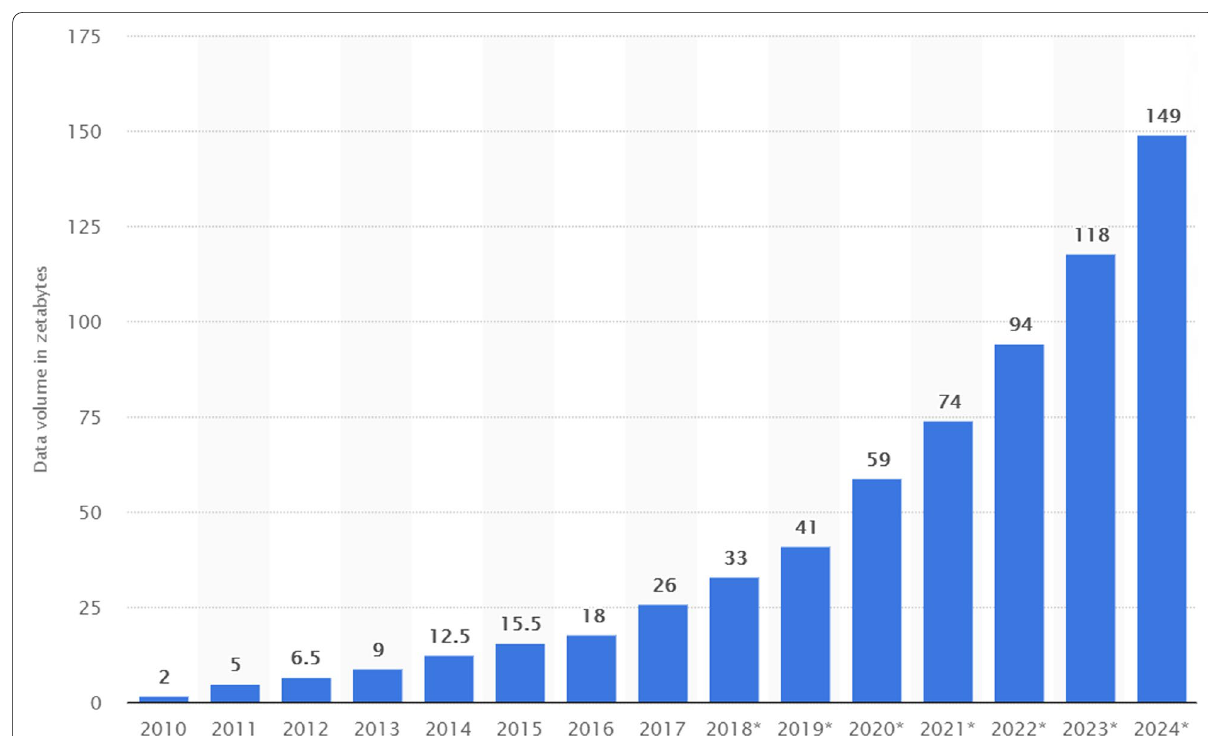
Fig. 1 Volume of data/information created, captured, copied, and consumed worldwide from 2010 to 2024 (estimated)